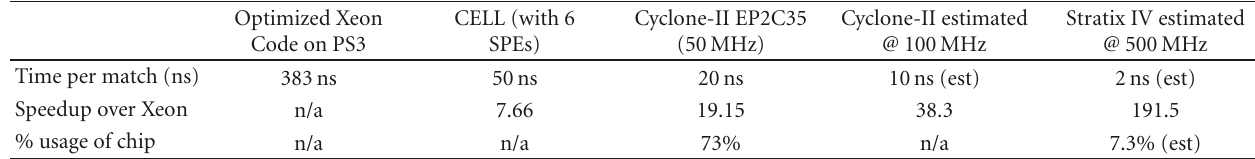
Figure 6: C++ code (highlighted) and IA-32 Assembly Code for Hamming Distance Calculations. Table 1: FPGA versus CPU comparison for iris match